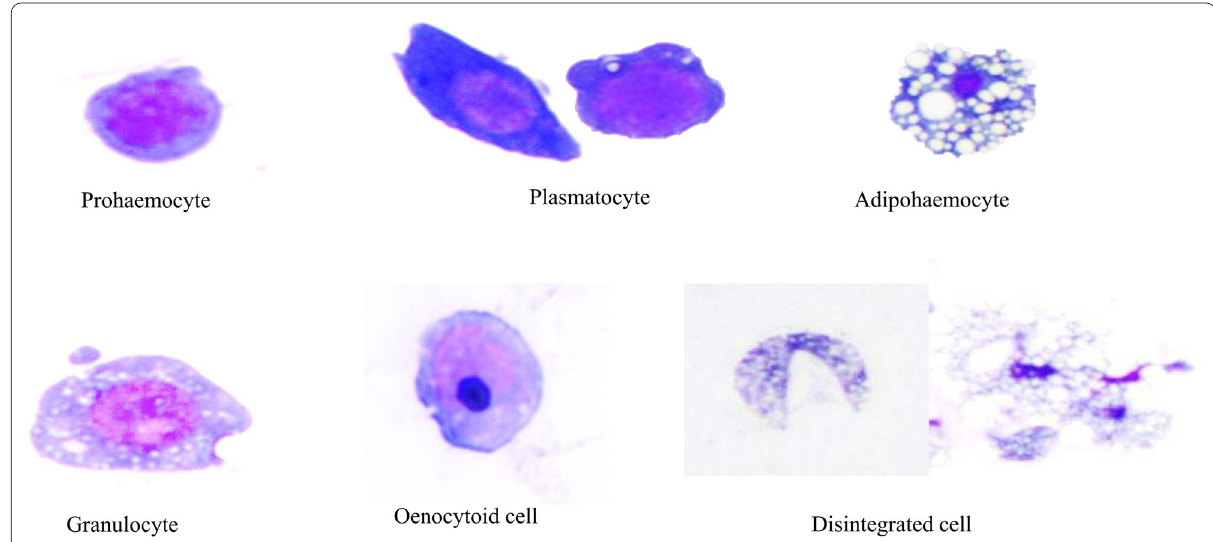
Fig. 1 Different types of haemocytes present in fifth instar nymphs of Dysdercus koenigii